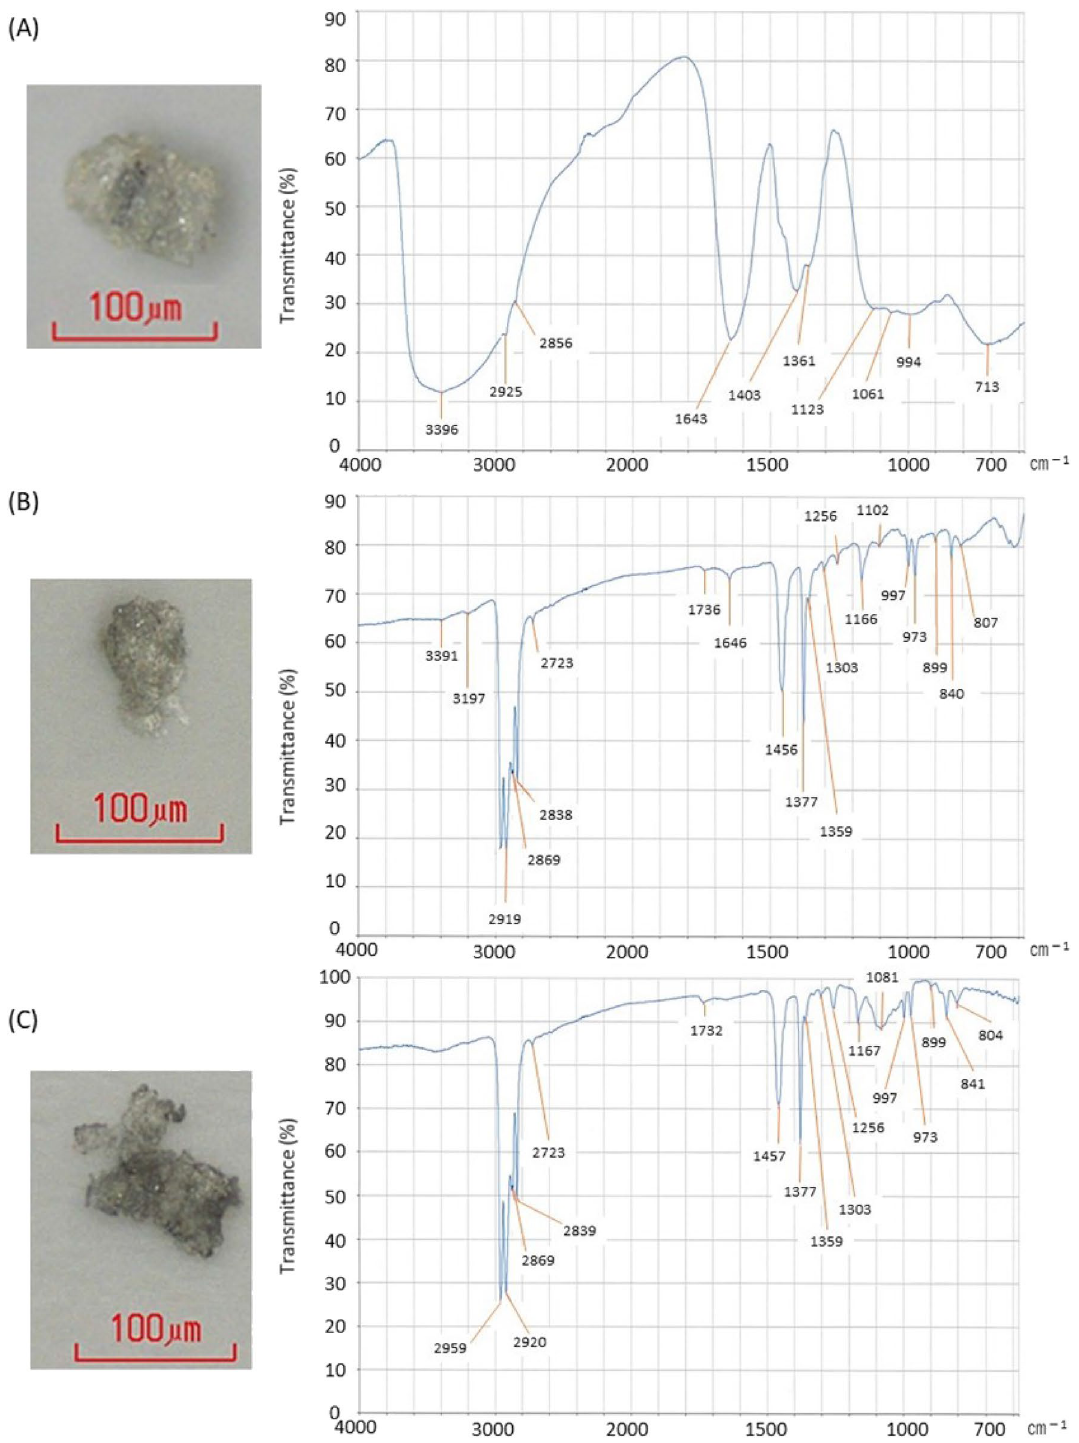
Figure 2. Visual and structural analysis of insoluble fine particles using microscopy and Fourier transform- infrared spectroscopy (FTIR). ( A ) A polysaccharide containing a carboxylic acid structure was considered as a contaminant by FTIR analysis. ( B ) FTIR analysis indicated that polypropylene was considered as the main component, and fatty acids were considered as the secondary component. ( C ) FTIR analysis indicated that the main component was polypropylene, and the possibility of silicone as an accessory component was